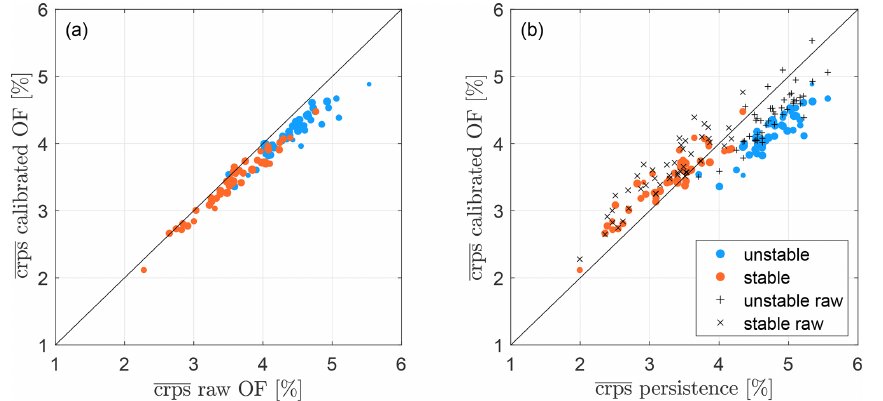
Figure 9. Scatterplots as described in Fig. 7. In (a) calibrated and raw observer-based forecasts are compared, and in (b) the calibrated observer-based forecasts in colour and the raw observer-based forecasts as black markers are compared to persistence.